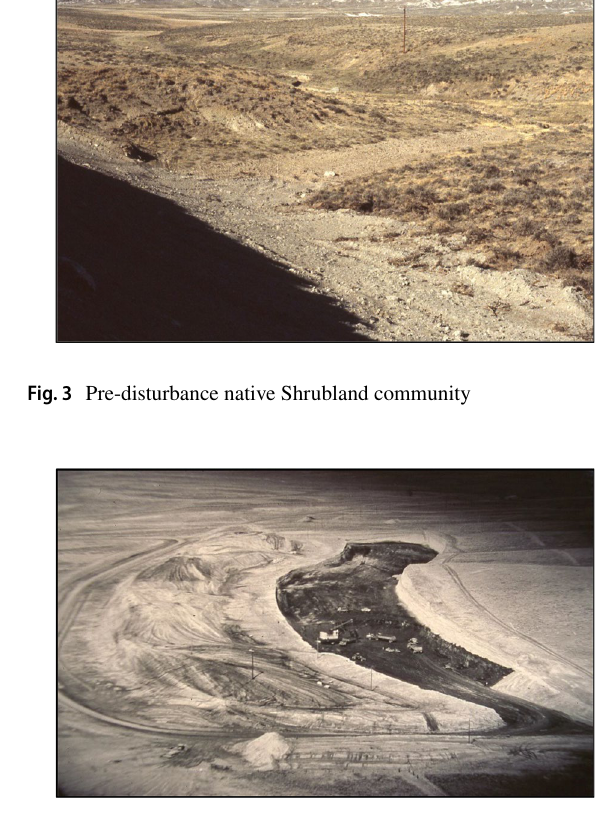
Fig. 4 Aerial view of the mine in